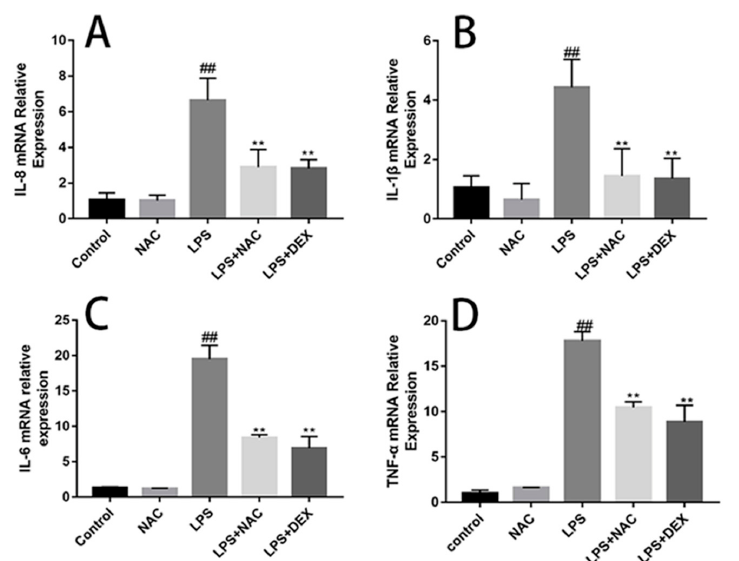
Figure 7. Effect of pre-treatment of NAC on the expression of inflammatory factors in lung tissue. The gene expression levels of IL-8 ( A ), IL-1 β ( B ), IL-6 ( C ), and TNF- α ( D ), as shown. GAPDH was used to normalize the gene expression data. TNF- α , IL-1 β , IL-8, and IL-6 expression levels were remarkably increased in the LPS group compared with those in control group. All results are expressed as the means ± SEM (n = 6 in each group). ## indicates p < 0.01 compared with the control group, and ** indicates p < 0.01 compared with the LPS group.